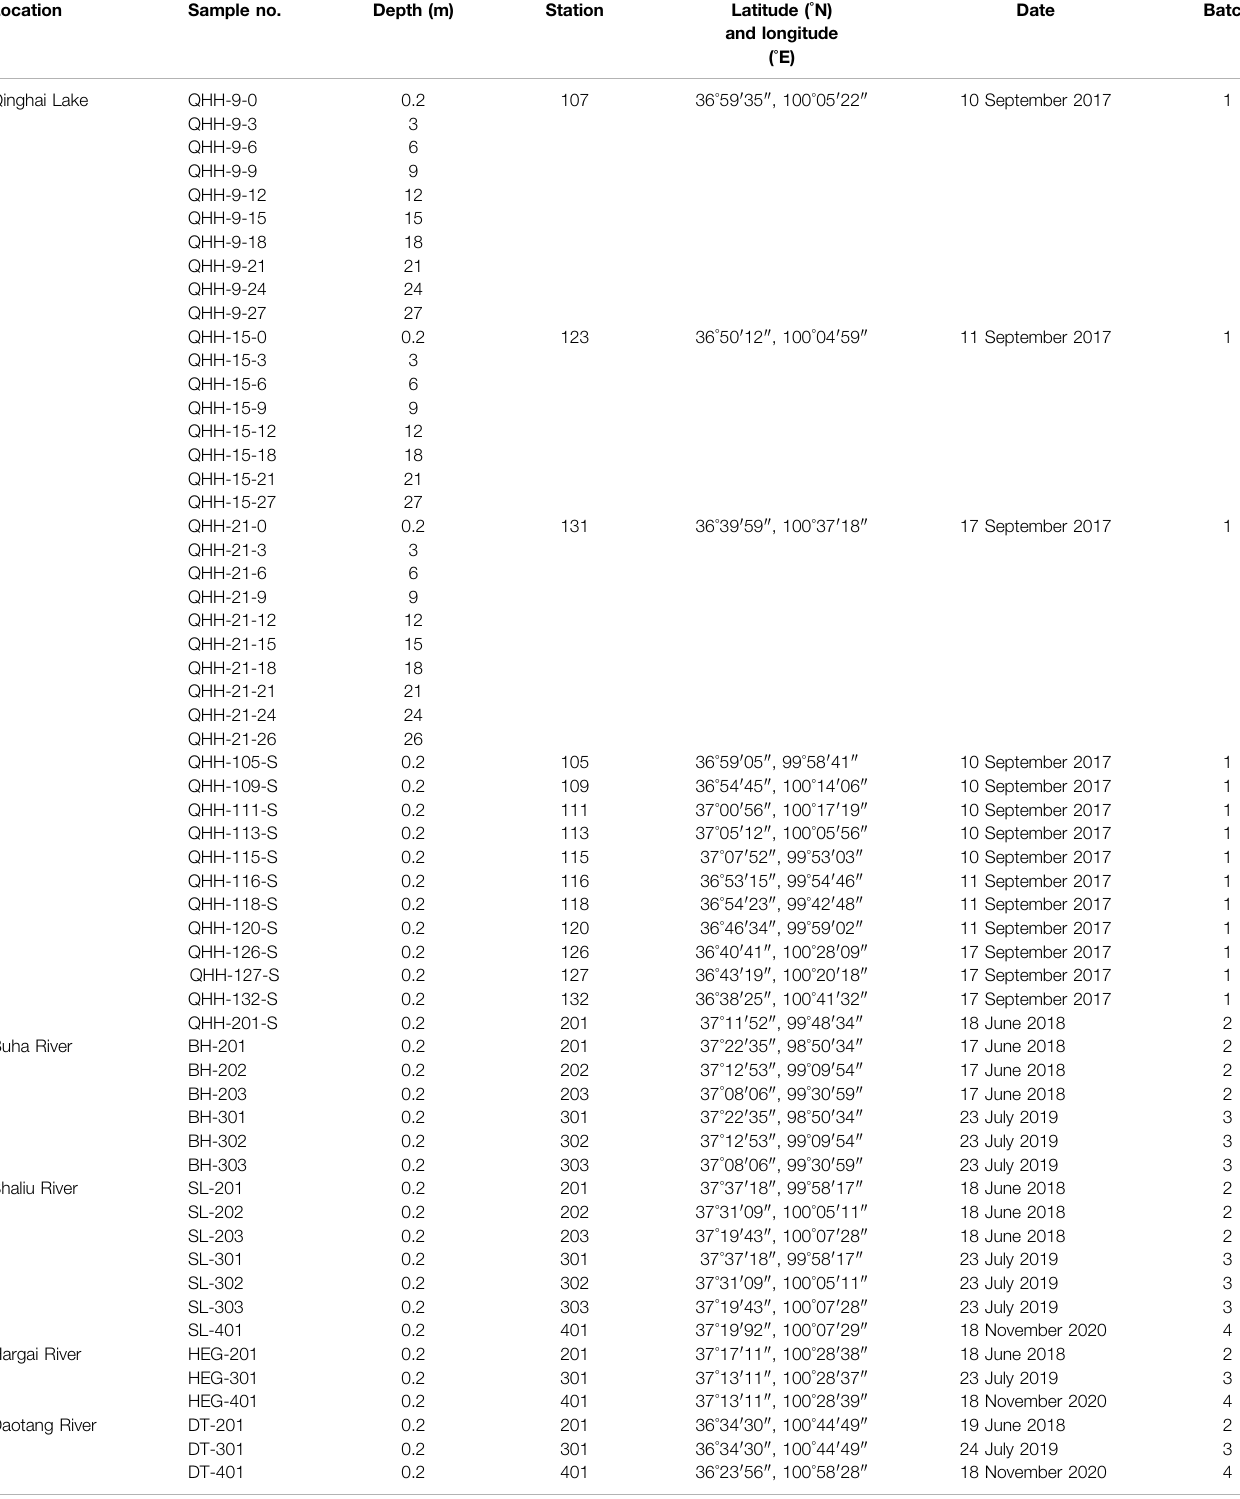
TABLE 1 | Sampling site information for the water samples. Location Sample no. Depth (m) Station Latitude ( ° N)